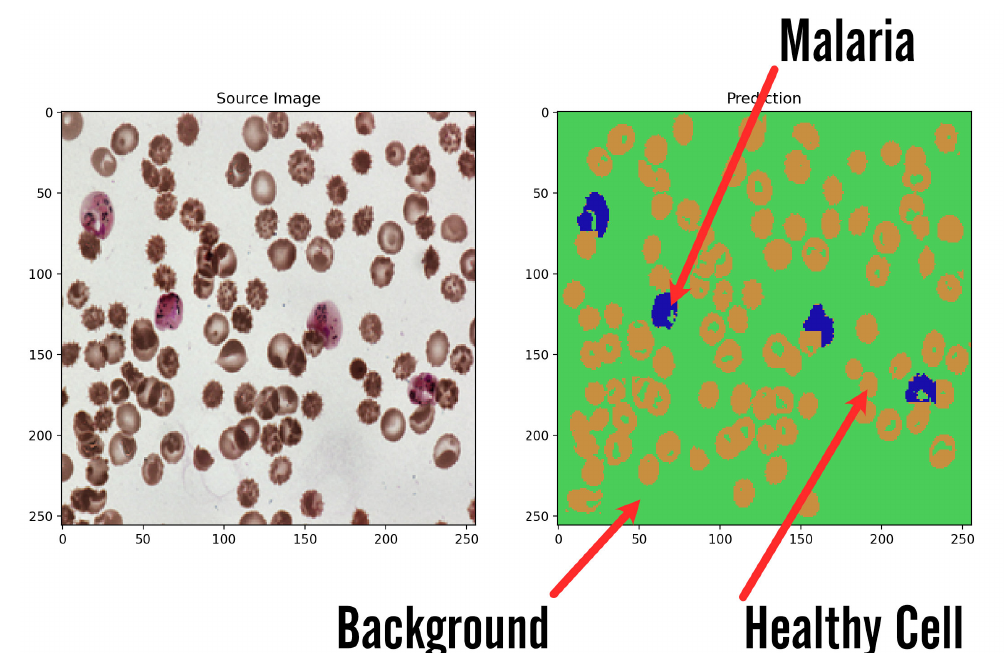
Figure 10. Sample result image presents how the systems returns results of classification. Input image is transformed into artificial background over which two types of blood cells are marked: healthy cells in regular features and malaria ones visible in irregular shapes and marked colors for better